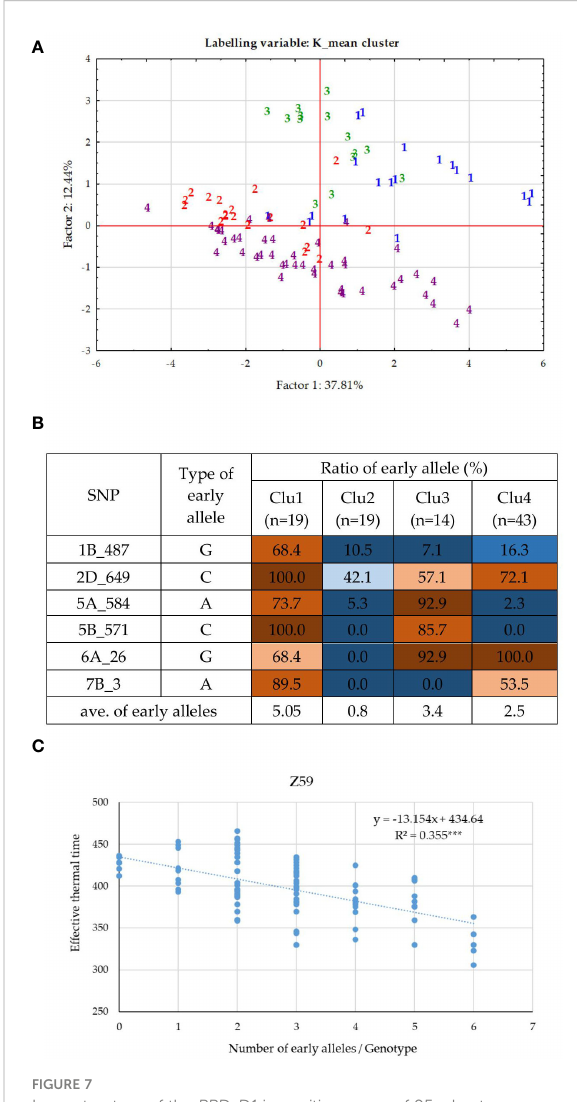
FIGURE 7 Inner structure of the PPD-D1 insensitive group of 95 wheat cultivars. (A) PCoA on the data matrix of the means of the fi ve consecutive developmental stages and six signi fi cant SNPs de fi ning plant development, (labelled by the cluster positions from the K- mean clustering protocol). (B) Allele compositions of the four K- mean clusters in the six SNPs de fi ning earliness. (C) Associations between the number of early alleles and heading